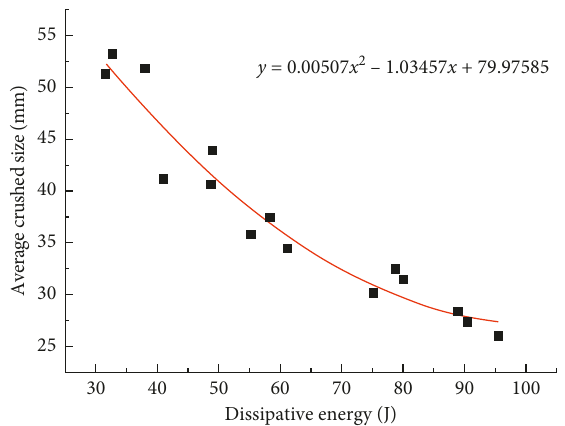
Figure 11: Relationship between the average crushed size and the dissipative energy of parallel-bedding shale under dynamic compression.